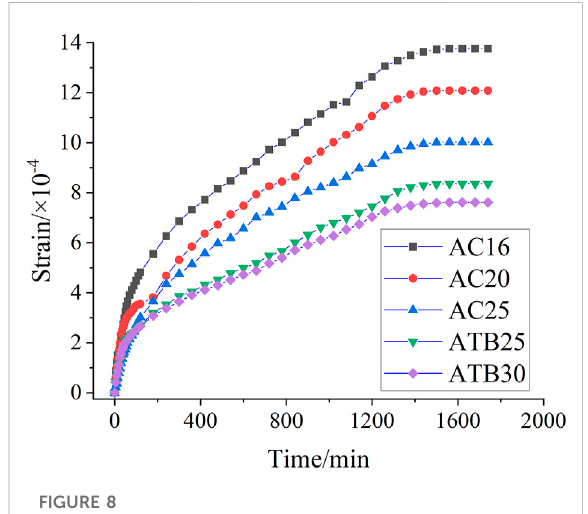
FIGURE 8 Relationship between the temperature shrinkage strain and time of the asphalt